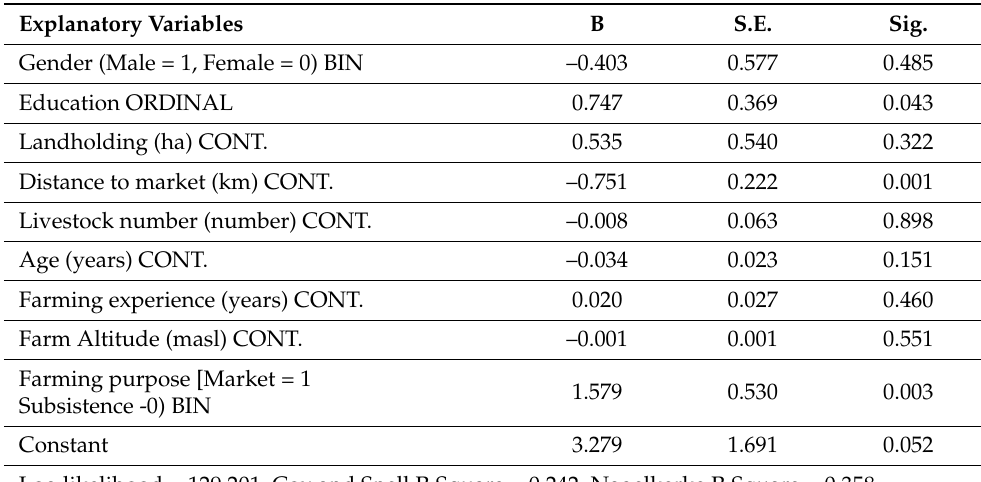
Table 9. Adoption of climate change mitigation measures in the study area. Explanatory